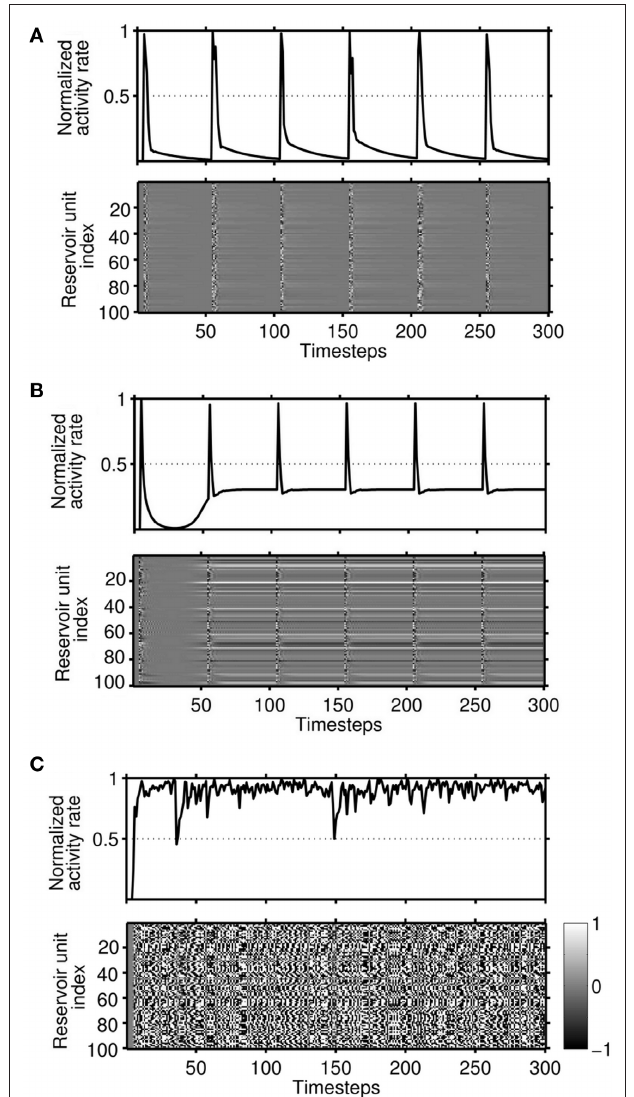
Figure 2 | responses of reservoirs to a repeated stimulus pattern for networks with R = 100 and different values of r . (A) For n = 2 clusters, stable dynamics occur where responses fade within a highly reproducible and fixed time-period, illustrating that the dynamics are input driven only. Shown is for both the normalized total activity rate (top) and reservoir activity (bottom). (B) With n = 20, transient dynamics were similar to stable but were characterized by activity decaying to a non-zero baseline. Baseline activity values for identical network configurations displayed high variability across trials. (C) Unstable dynamics for n = 50, where the system never returns to zero activity after the first input.